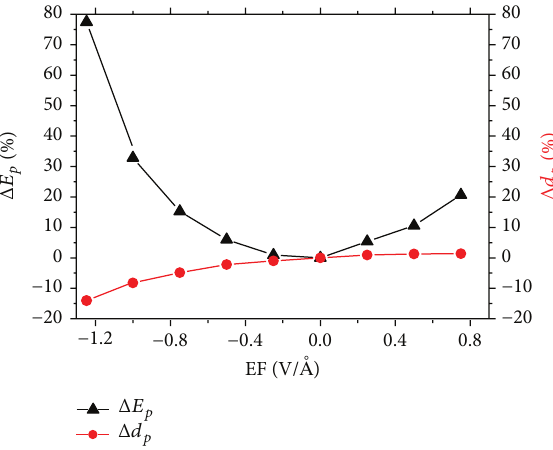
Figure 4: Effects of EF on physisorption energy and physisorption bond